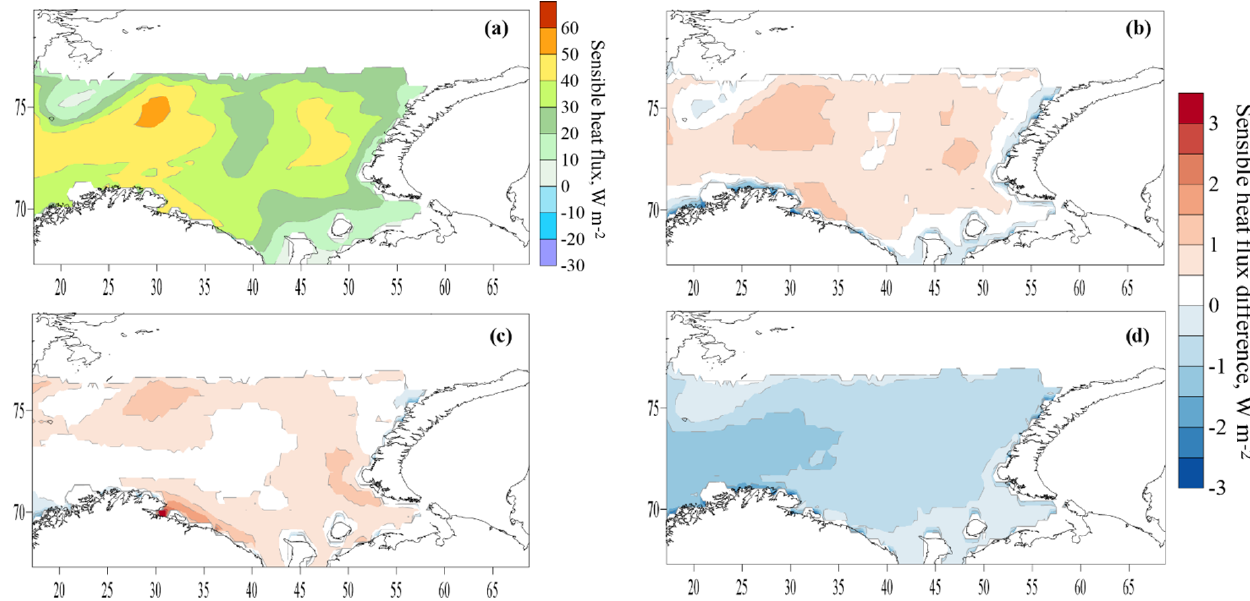
Figure 11. Mean sensible heat flux in experiment C55 (a) and the difference in the sensible heat fluxes between experiments T1–C55 (b) , O2–C55 (c) and D3–C55 (d) . All grid nodes where sea ice was in more than half of the cases are filtered